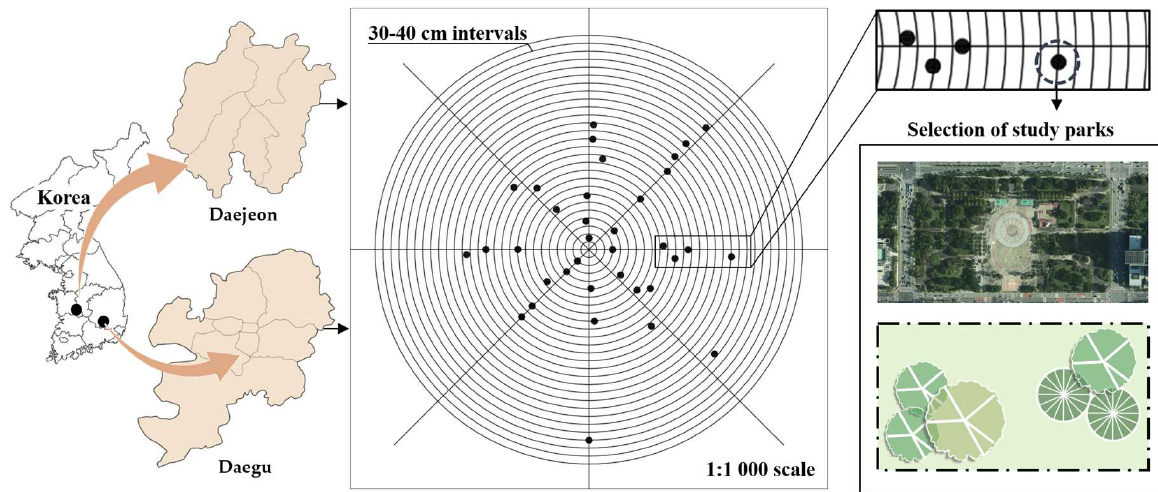
Figure 1. Depiction of systematic sampling method to select study